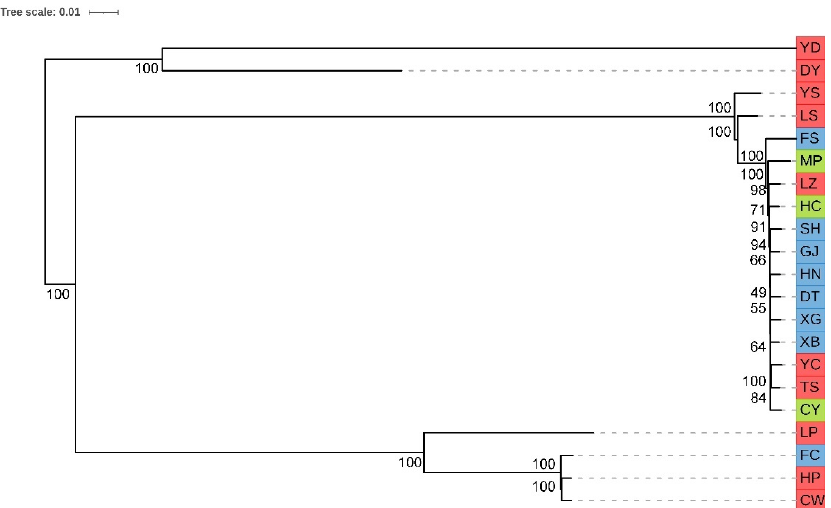
Figure 4. Neighbor-joining tree of 21 pine wood nematode isolates inferred from whole genome SNPs. Branch colors indicate isolate origins: red represents isolates from the subtropical zone; green represents isolates from the warm temperate zone; and blue represents isolates from the mid-tem- perate zone. The stability of the nodes was assessed by bootstrap analysis with 1000 replications and bootstrap values are shown at the corresponding nodes. Solid lines represents foe the branch length, and dashed lines are generated after the alignment of labels.